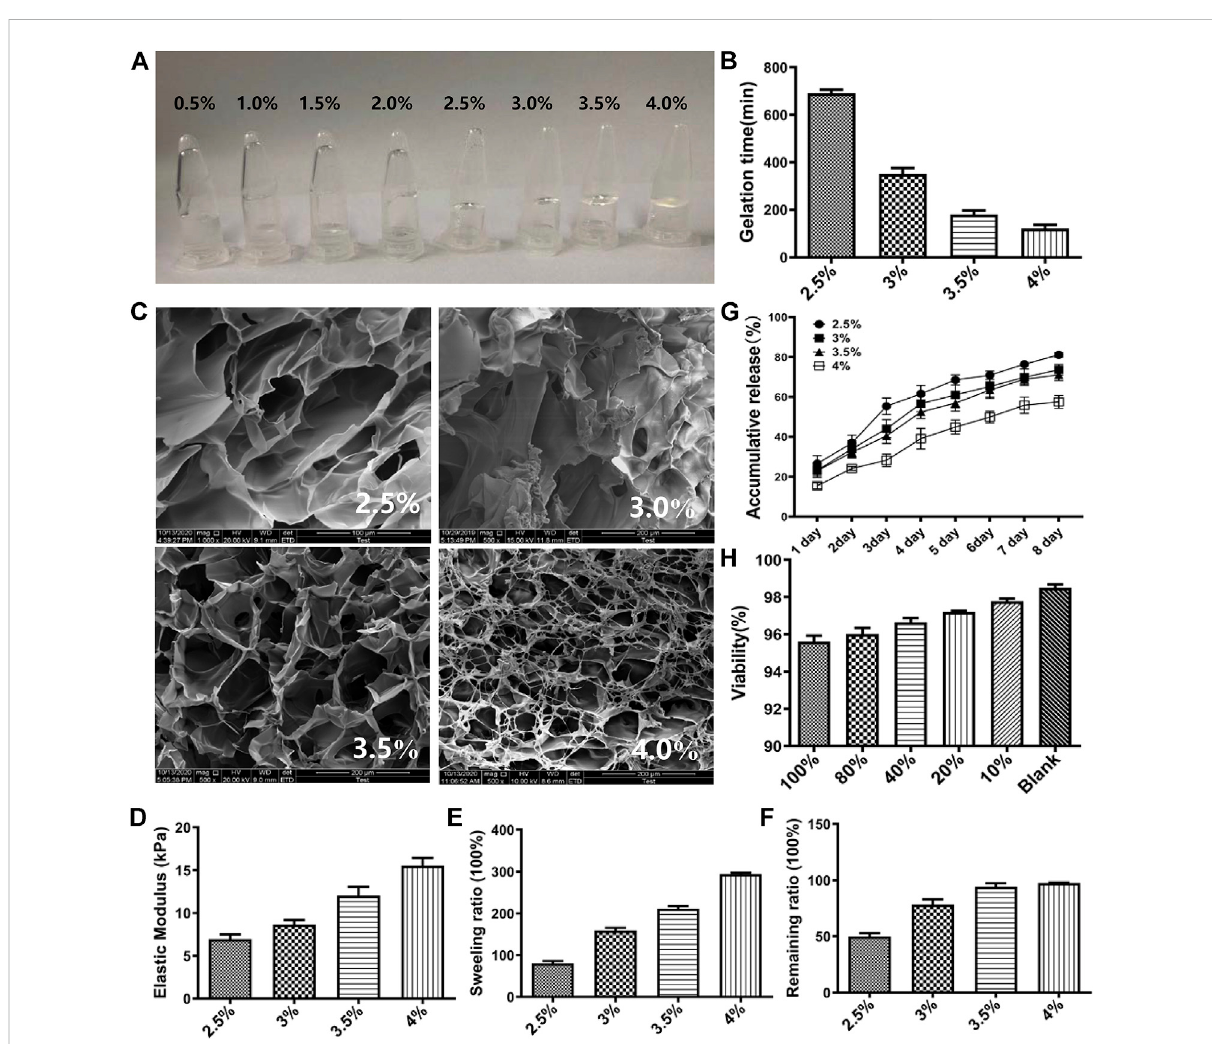
FIGURE 3 CharacterizationofHA-F127. (A) Theappearanceof0.5%,1.0%,1.5%,2.0%,2.5%,3.0%,3.5%,4.0%HA-F127.Itwasobviousthat0.5%,1.0%,1.5%, 2.0%HA-F127didnotsolidi fi ed; (B) Thegelationtimesof2.5%,3.0%,3.5%,4.0%HA-F127; (C) TheTEMof2.5%,3.0%,3.5%,4.0%HA-F127; (D) , (E) , (F) , and (G) The elastic modulus, swelling ratio, remaining ratio and release of 2.5%, 3.0%, 3.5%, 4.0% HA-F127, respectively. (H) The RMSCs proliferation in under different concentration of